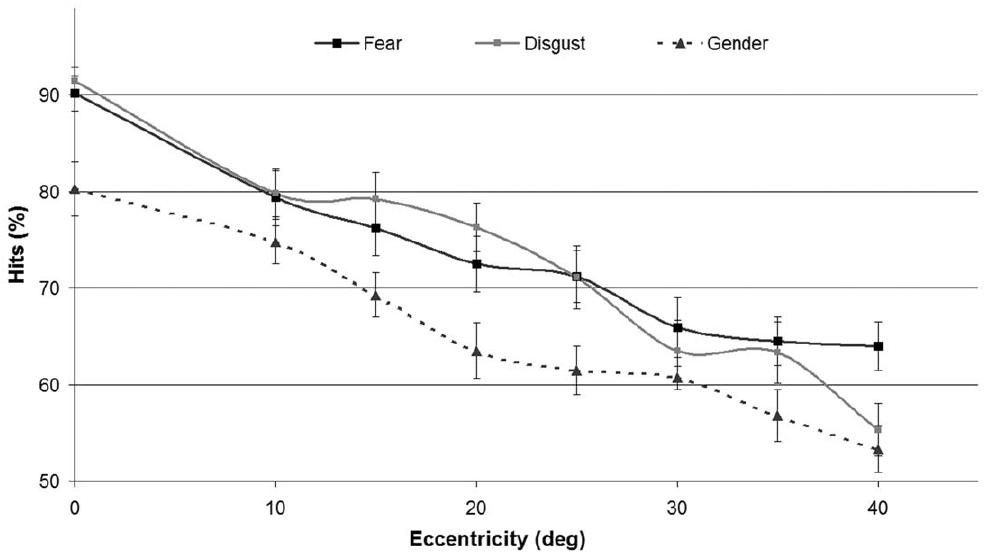
Figure 2. Percentage of correct responses in the three discrimination tasks as a function of eccentricity. Vertical bars represent standard errors of the mean values.